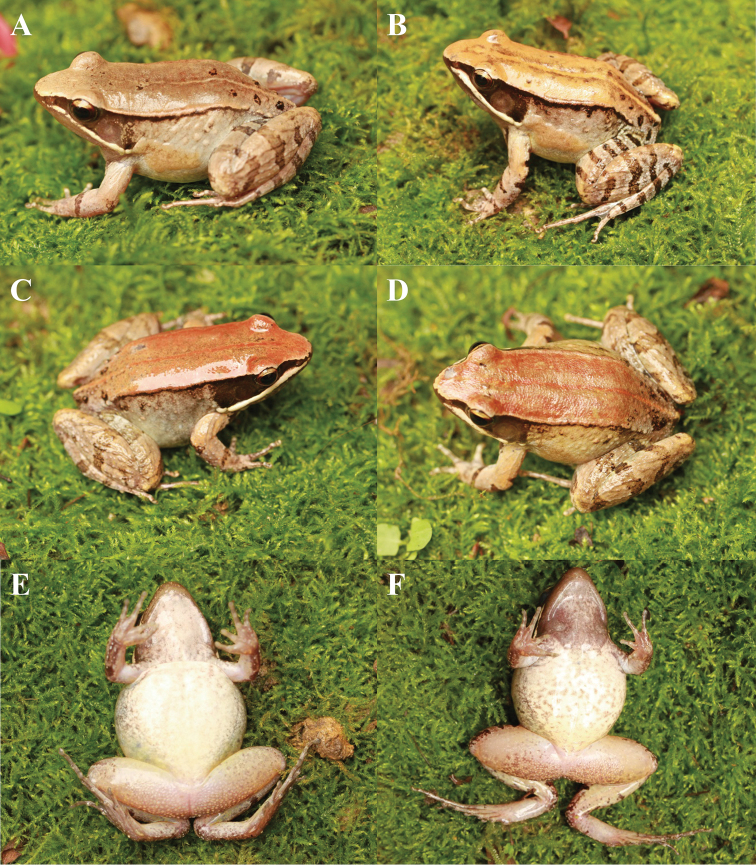
Colour variation in Nidirana
yeae sp. nov. A Dorsal view of male specimen CIBTZ20190608003 B dorsal view of male specimen CIBTZ20190608016 C dorsal view of female specimen CIBTZ20190608005 D dorsal view of male specimen CIBTZ20190608006 E ventral view of male specimen CIBTZ20190608006 F ventral view of female specimen CIBTZ20190608005.